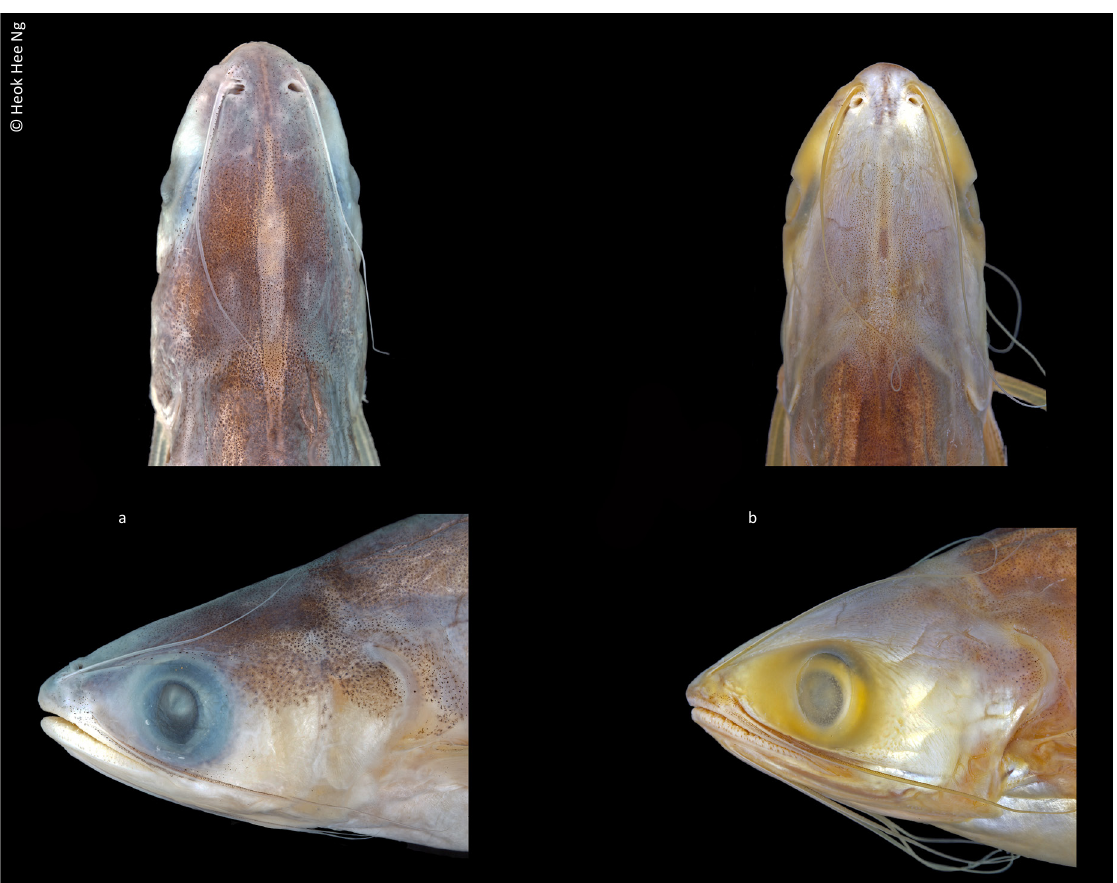
Image 2. Dorsal and lateral views of heads of: (a) - Eutropiichthys cetosus sp. nov., PUCMF 13024, holotype, 121.8mm SL; (b) - E. burmannicus , ZRC 43514, 121.8mm SL, showing differences in snout shape. Images not to